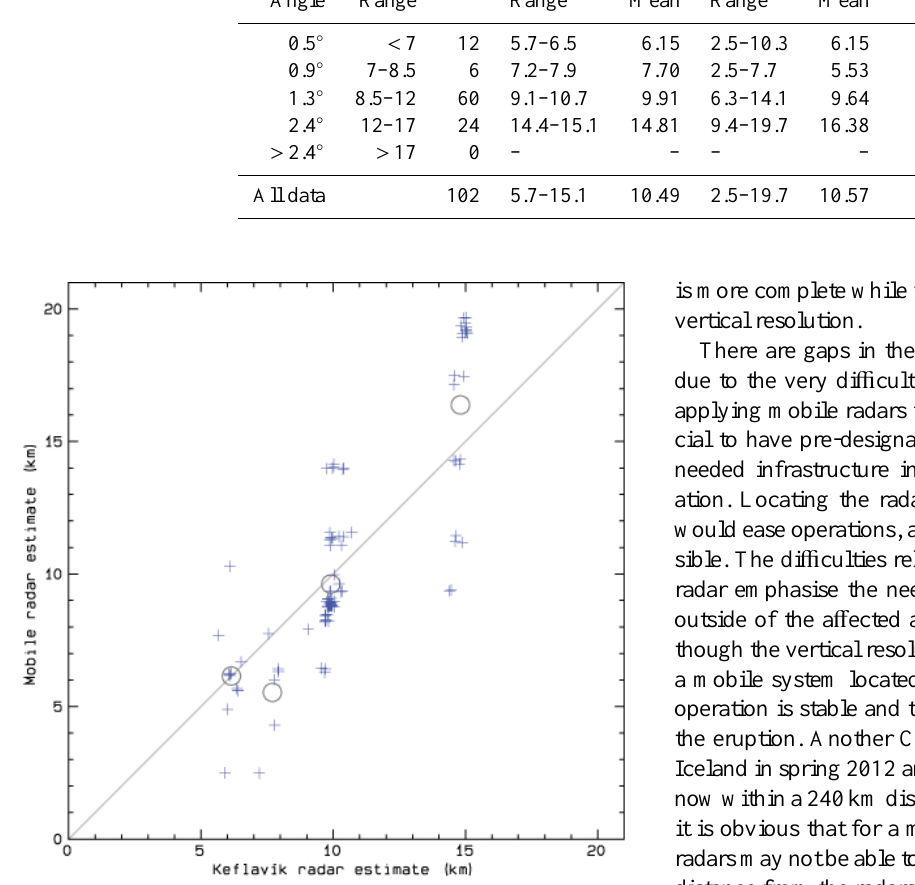
Figure 6. Comparison of synchronous plume-top altitude estimates by the two radars. The circles show mean values of clusters for the Keflavík radar elevation angles (see Table